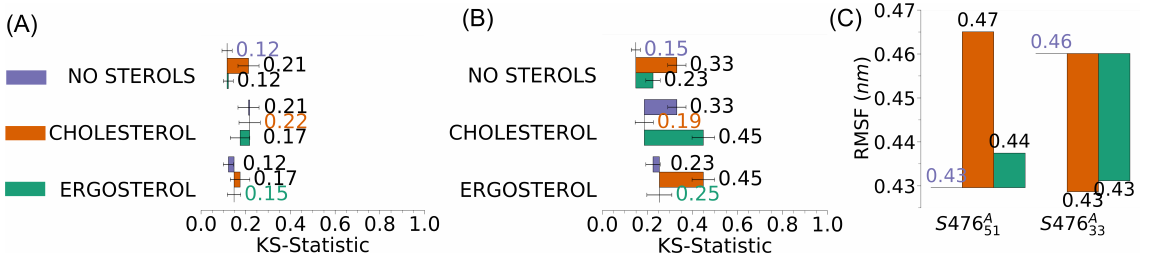
51 and S476 A membranes, without 33 51